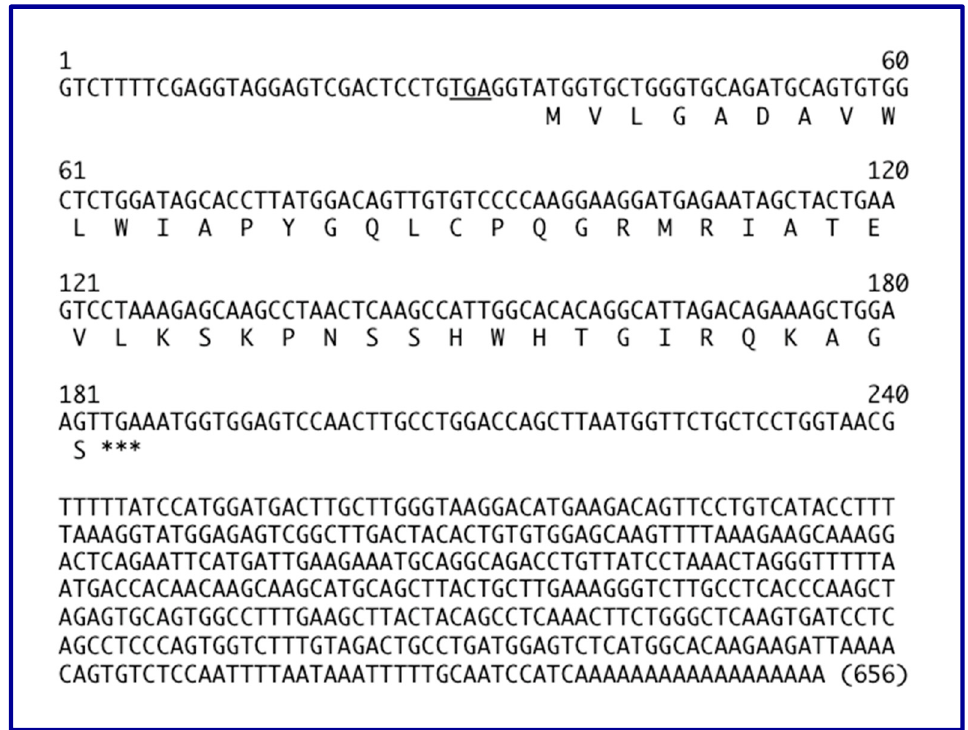
Figure 6. Conceptual translation of one of the 24 human GAS5 transcript isoforms (NR_002578; 656 nucleotides) predicts a 153 nucleotide smORF encoding a 50-amino acid smORFtide. This 153 nt